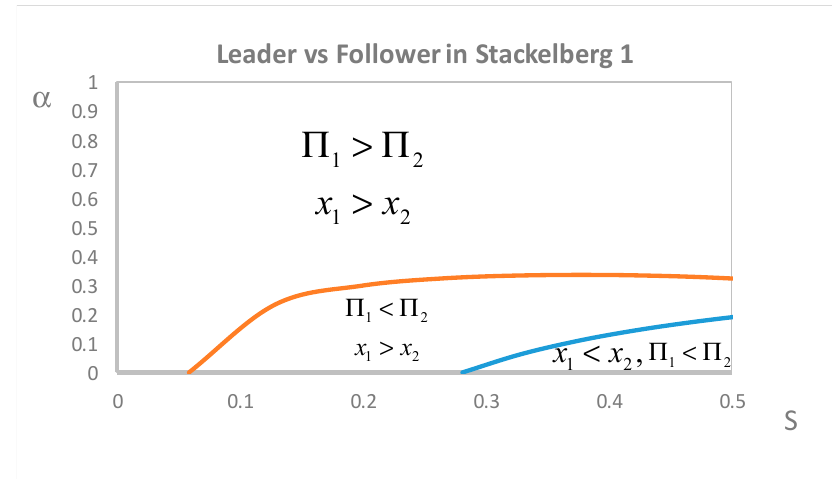
Figure 1. Output and profit comparison (leader vs. follower) in model Stackelberg 1 (Propositions 2 and 3). Π i ( x i ) stands for profit (output) of firm i ( i =